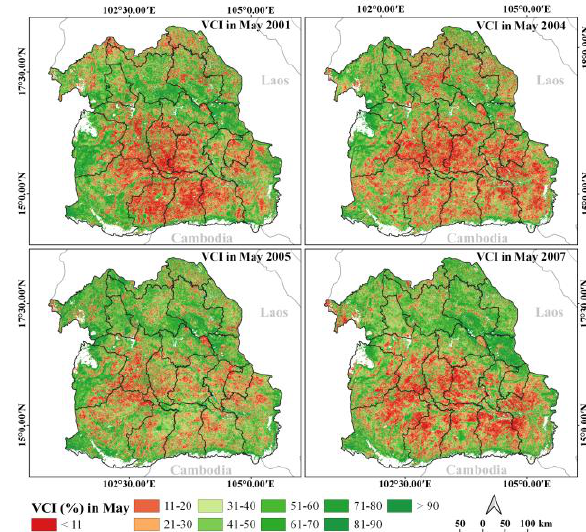
Figure 9. Inter-annual variability for single-time step (May) with drought in Northeast Thailand in 2001, 2004, 2005 and 2007 based on the vegetation condition index (VCI)